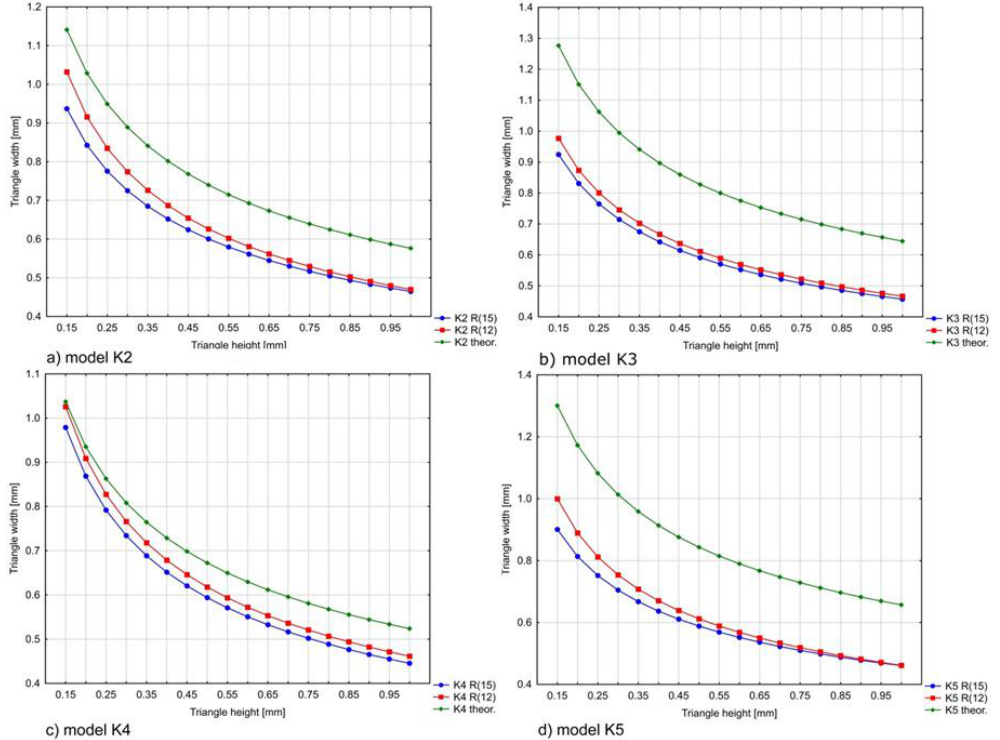
Figure 10. Comparison of performed regression models (cards K2–K5) with theoretical curve. Blue curve is the model that includes all responses; red curve is the model without the three rejected surveys; and green curve is the theoretical values according to P c formula. ( a ) Model K2; ( b ) Model K3; ( c ) Model K4; ( d ) Model K5.